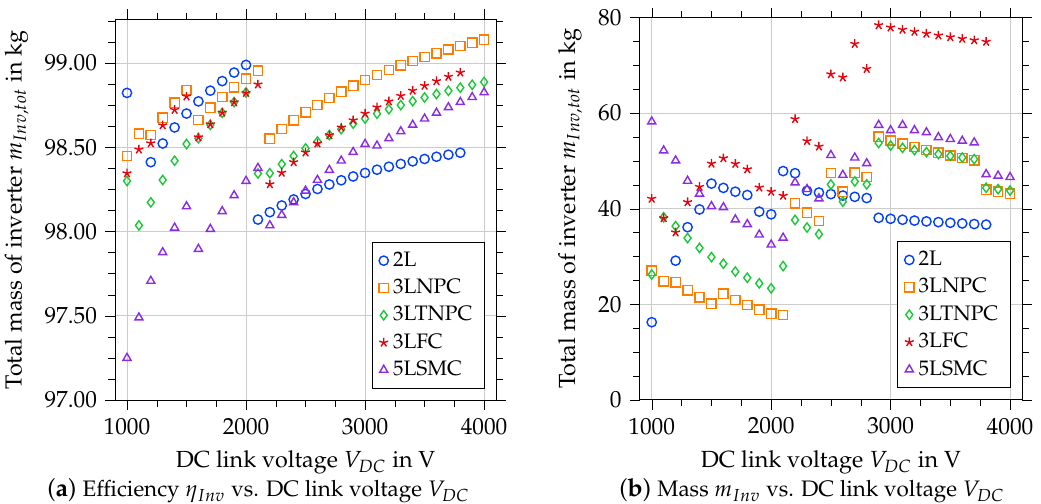
Figure 5. Efficiency η Inv and gross mass m Inv for varying DC link voltage V DC and different inverter topologies ( P EM , el = 1.0MVA, cos ϕ = 0.85, T chip = 150 ◦ C, T amb = 75 ◦ C and f EM , el = 1000Hz).